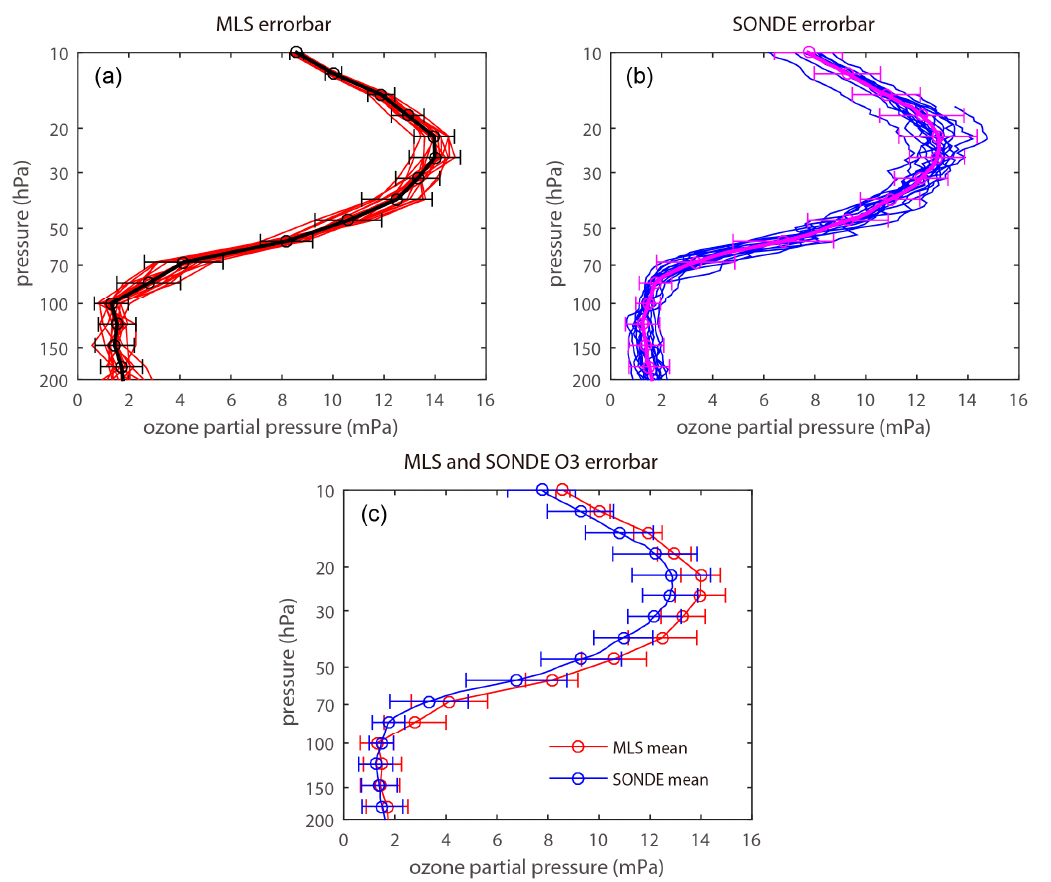
Figure 2. ( a ) Ozone profiles (red) and the mean profile with ±2 standard deviation (black) derived from MLS data. ( b ) As in (a), but derived from ozonesonde data. ( c ) Mean ozone profiles with ±2 standard deviation for MLS (red) and ozonesonde (blue).